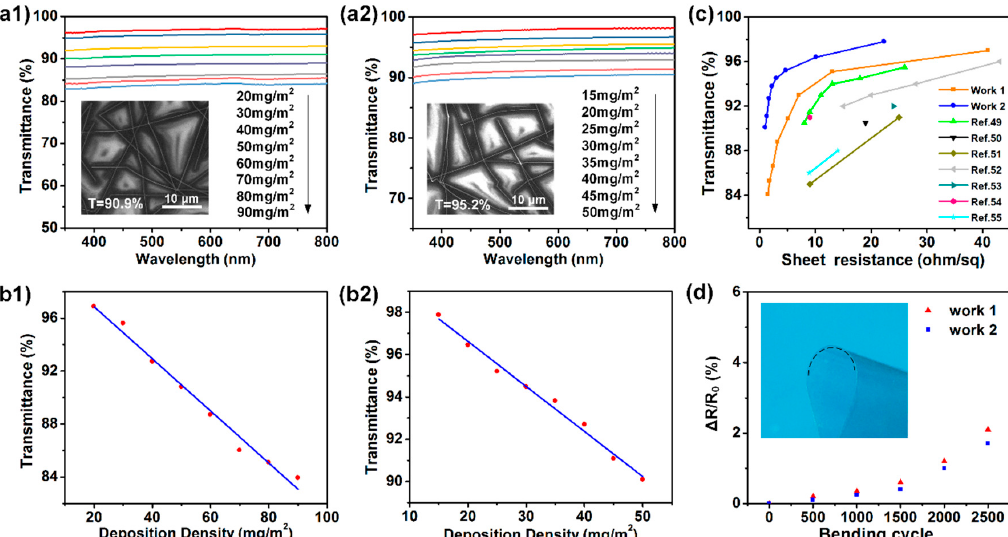
Figure 7. The transmittance of transparent conductive films (TCFs) varied with AgNW deposition density in ( a1 ) work 1 and ( a2 ) work 2. The transmittance of TCFs at 550 nm varied with deposition density in ( b1 ) work 1 and ( b1 ) work 2. ( c ) Transmittance versus sheet resistance for TCFs of our work and other reported results. ( d ) The resistance change of the TCFs after being subjected to repeated bending. Insets in Figure a1, a2 are SEM images of TCFs with optical transmittance of 90.9% and 95.2%, respectively. The inset in Figure d shows the bending angle of 180 ° .